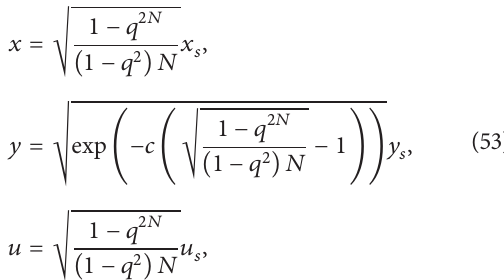
and 𝛽 ∈ R and saddle point if 𝜉 < 0 and 𝜆 ̸= 1 .